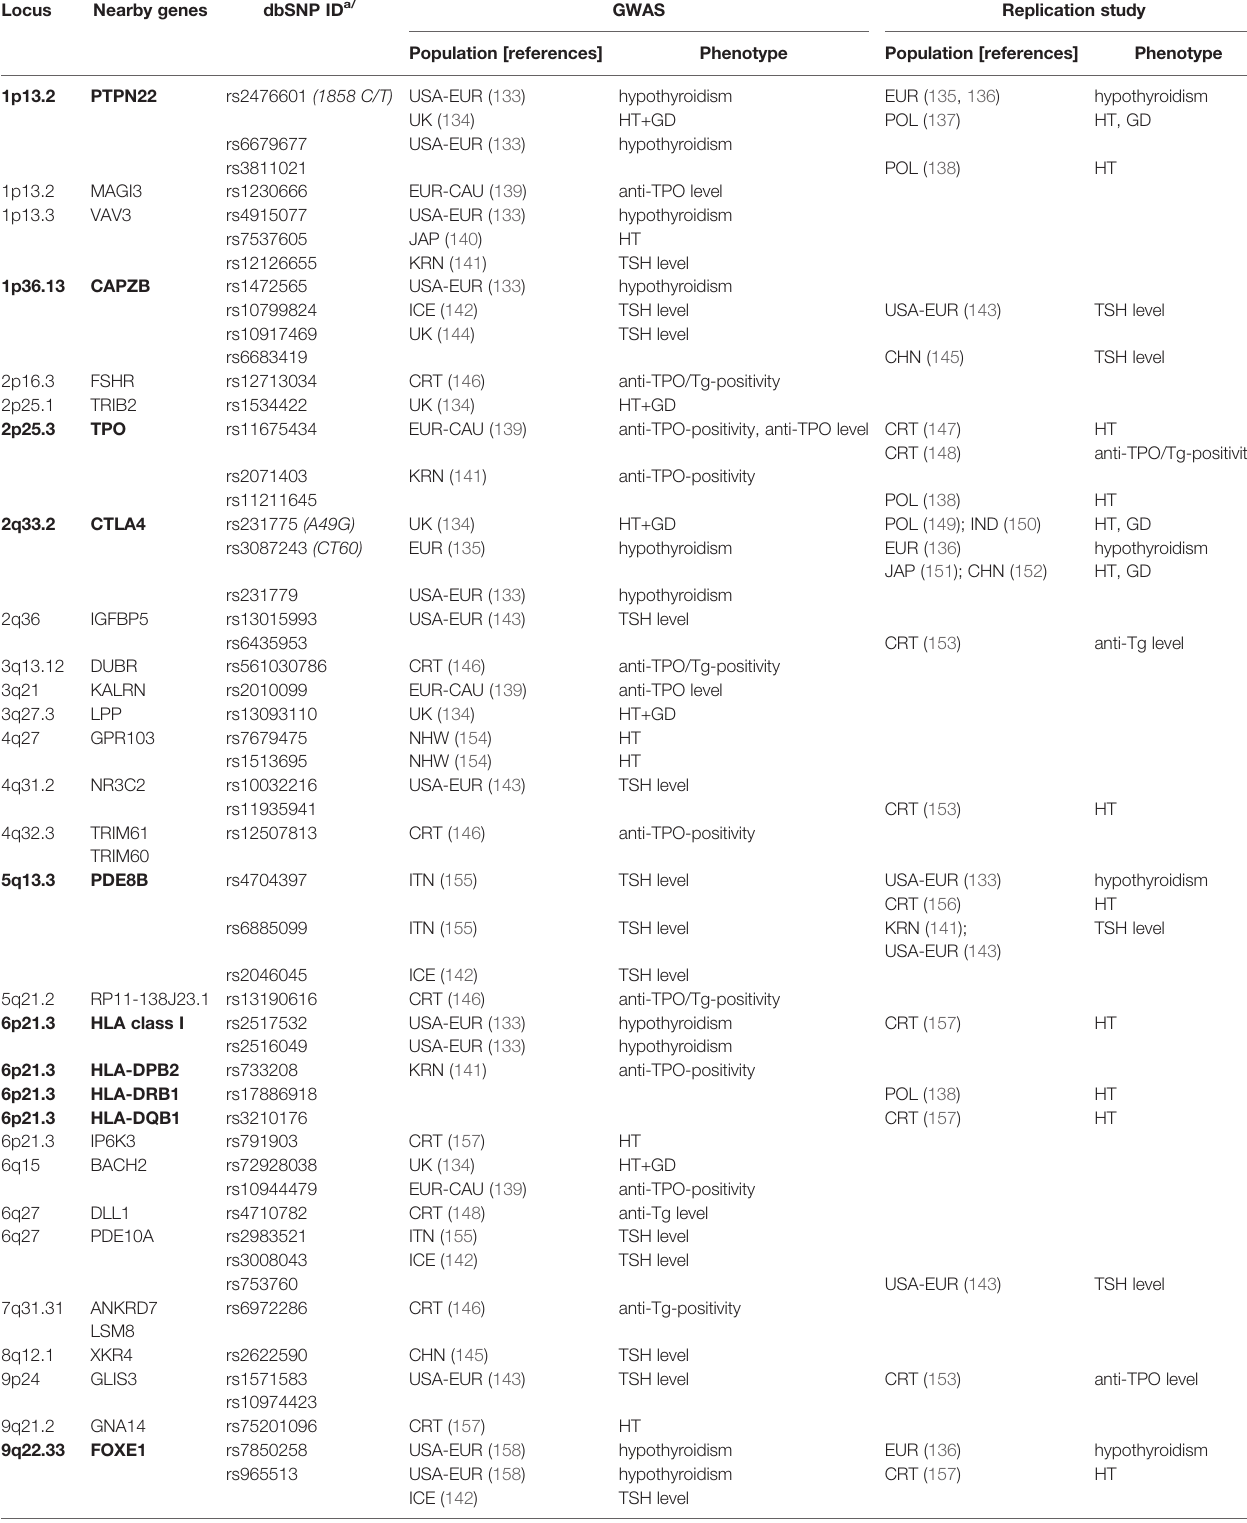
TABLE 2 | GWAS and replication studies for AITD and thyroid dysfunction traits susceptibility.